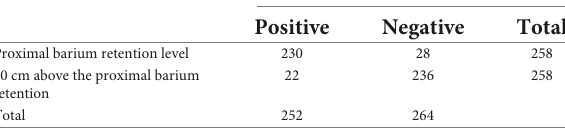
TABLE 1 24-h delayed film of barium enema and final pathological results in HSCR patients.